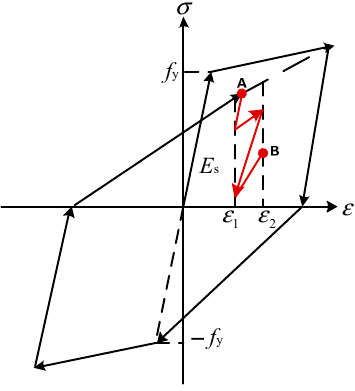
Figure 2. The cyclic constitutive model of steel. Figure 3. The stress error of steel under cyclic loading.